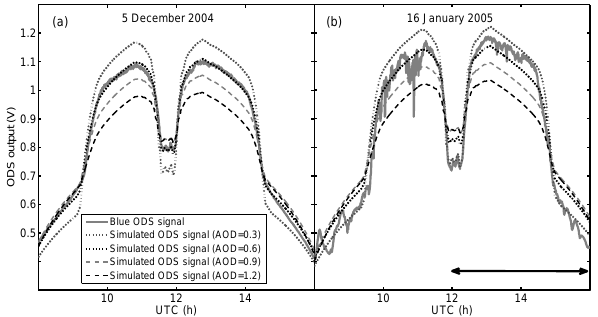
Figure 8. Comparison between ODS blue channel observed output voltage and simulated blue ODS signal for AOD values of 0.1, 0.6 and 1 (a) in cloud-free conditions on 5 December 2004 and (b) on 16 January 2005 in cloudy